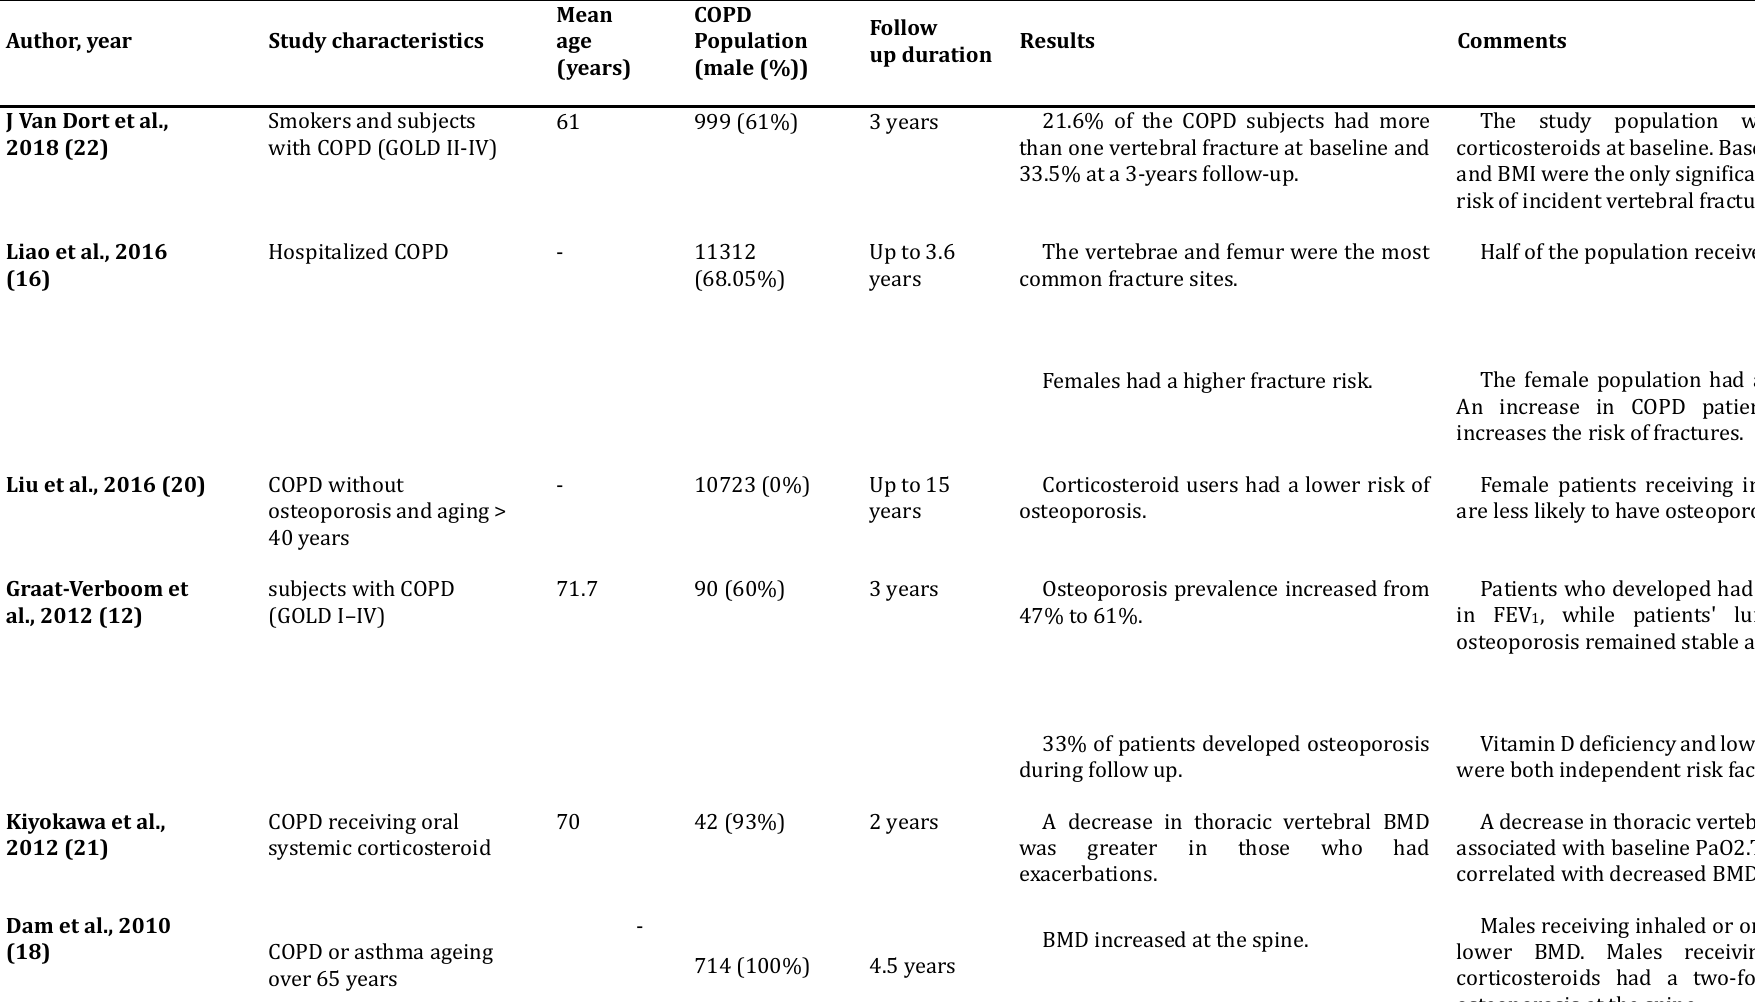
Table 1. Follow up studies evaluating osteoporosis or bone fracture in COPD patients